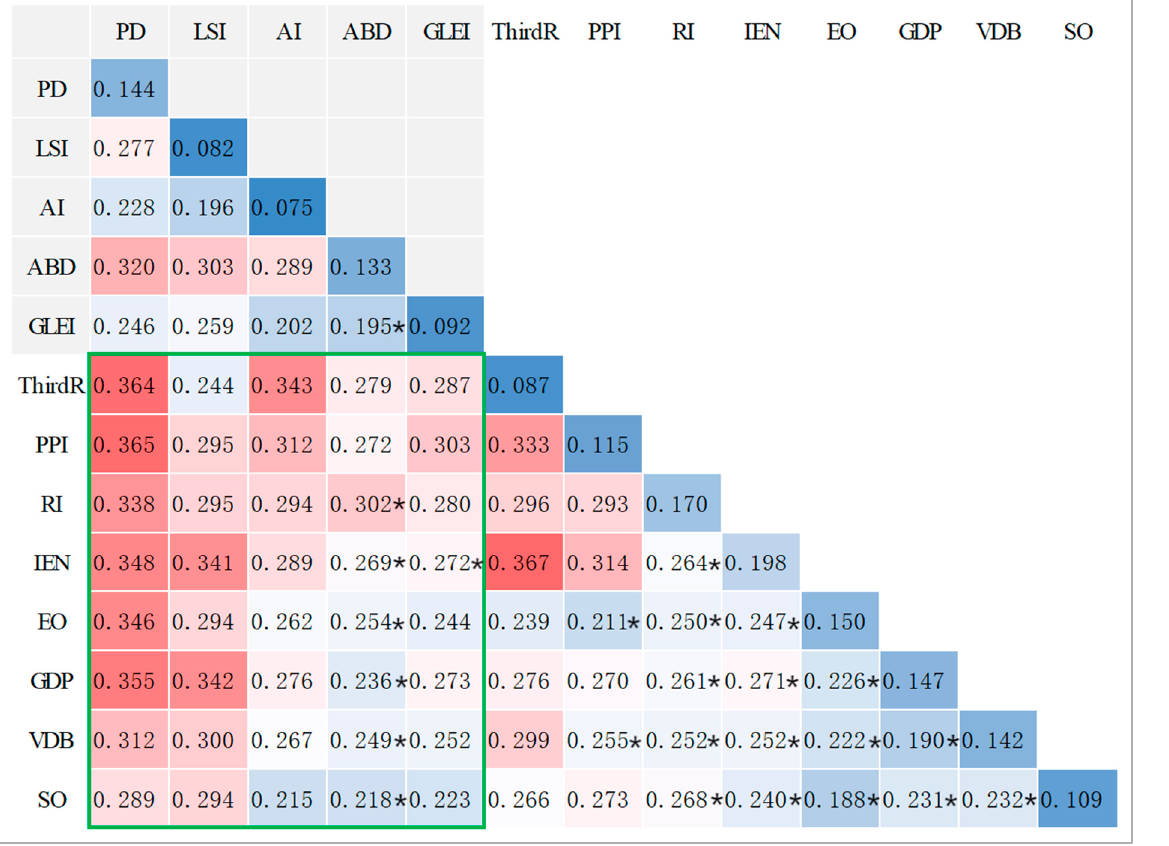
Figure 7. The results of interaction detection. Note: (1) From blue to red, the effect of interaction goes from small to large. The darker the blue, the smaller the effect, and the darker the red, the greater the effect; (2) Band * is mutual enhancement, while the rest are nonlinear enhancement.